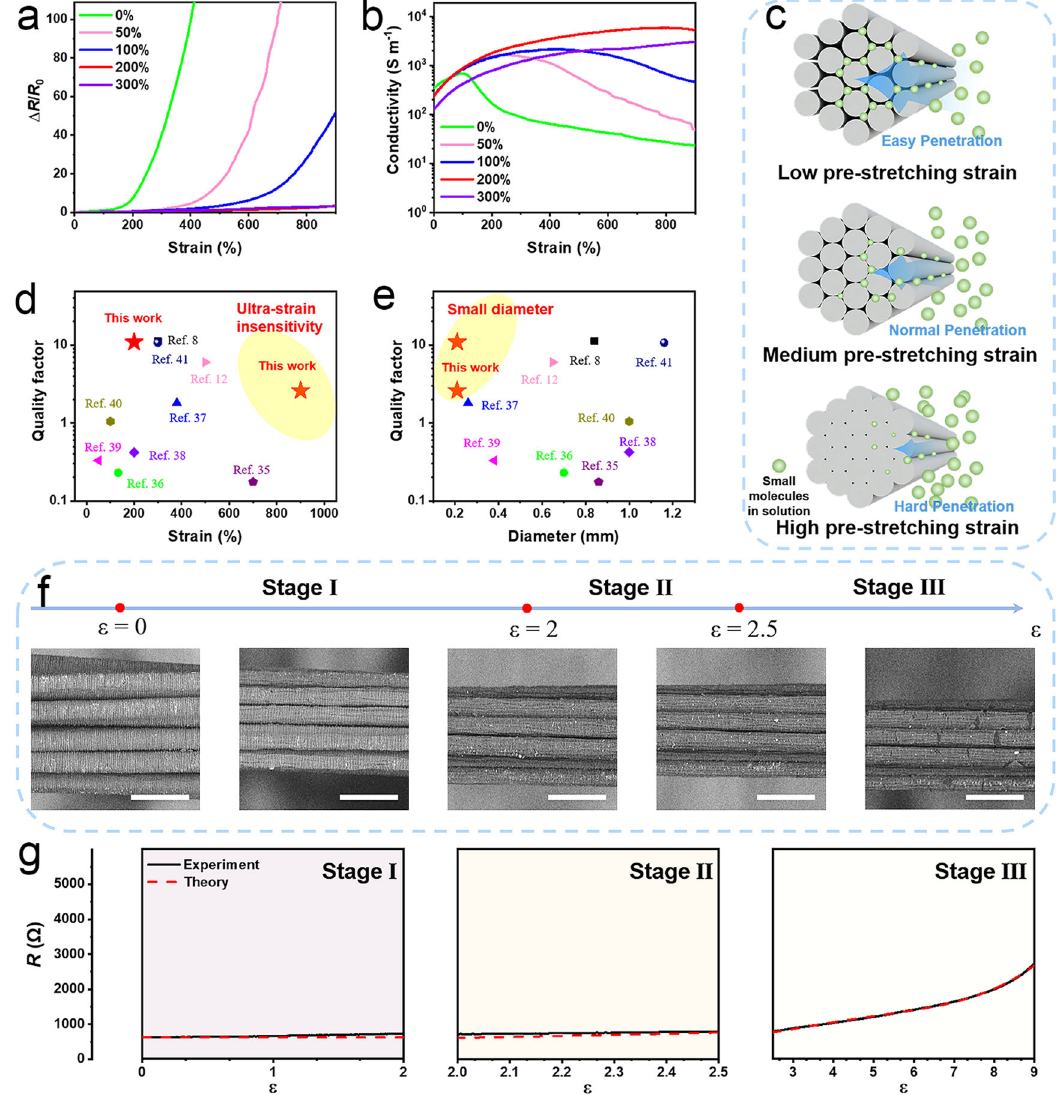
Fig. 4 Electrical properties of multi fi lament with different pre-stretching strains. a Relative resistance change of PU 420D increasing strain. b Conductivity-Strain curves of PU 420D stretching strains on small molecule (such as DA, FeCl 3 , NaSSA, and Py represented by green spheres). d - e Comparison of PU 420D 1D conductor reported in the literature (Ref. 8,12,35 – 41 ). f SEM images and g the resistance of PU 420D 100 μ